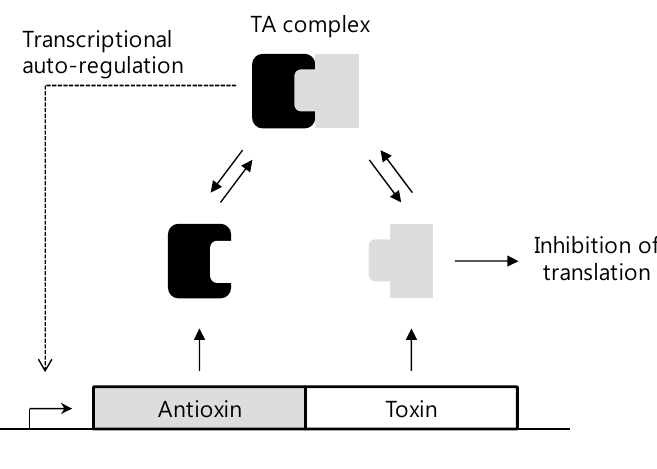
Figure 4. Mechanism of TA